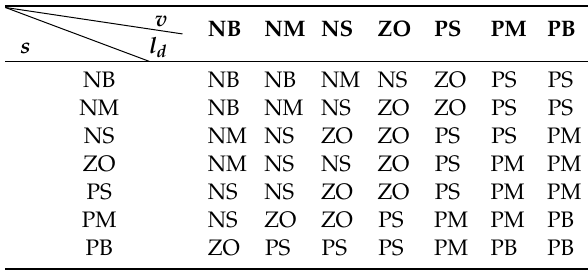
Figure 9. Membership functions. ( a ) Membership functions of v . ( b ) Membership functions of